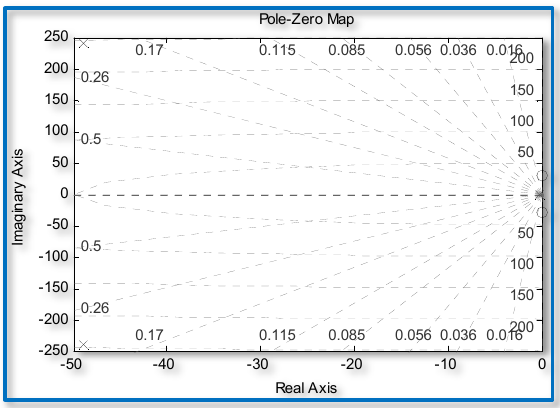
Figure 9. Zero ‐ pole diagram of the controlled object exported by Matlab. Figure 9. Zero-pole diagram of the controlled object exported by